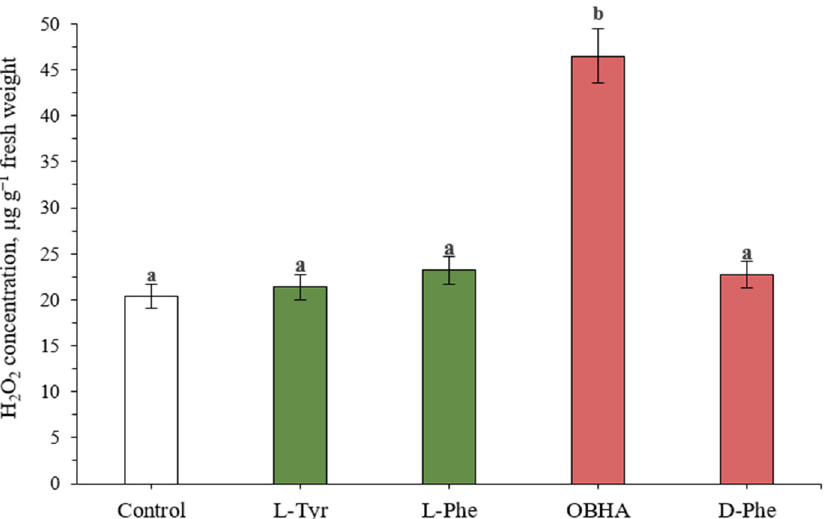
Figure 3. Concentration of hydrogen peroxide in wheat samples incubated on a nutrient medium supplemented with 500 µ M of active compounds. Bars marked with different letters show the significant differences at ( p ≤ 0.05) according to Tukey’s test.